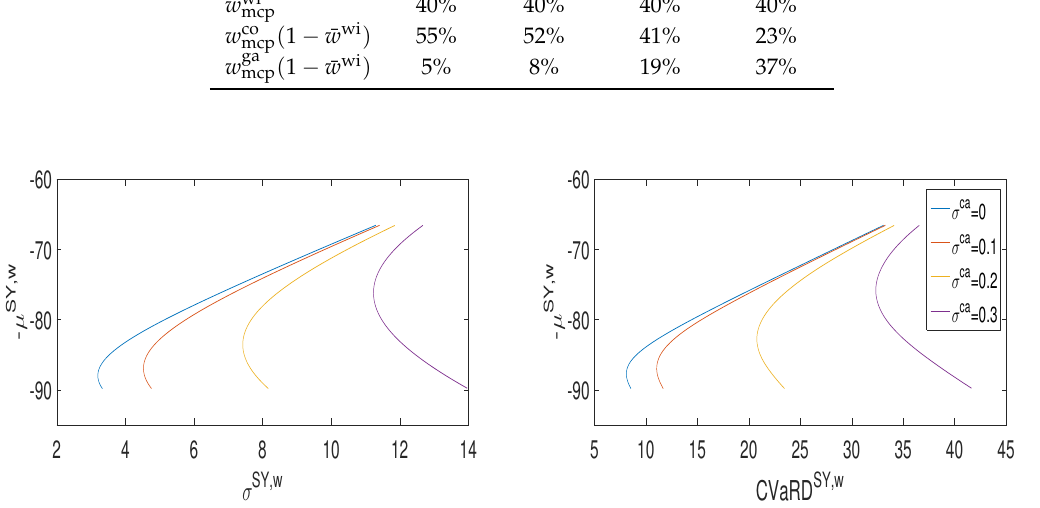
Figure 2. Efficient system portfolio frontiers. Each graph plots 4 system portfolio frontiers (for σ ca = 0, 0.1, 0.2, 0.3) for β co = 0 = β ga . The wind penetration is ¯ w wi = 40%. Left panel: The ( − µ SY,w , σ SY,w ) plane. Right panel: The ( − µ SY,w ,CVaRD SY,w ) plane. The σ ca = 0 case is the leftmost